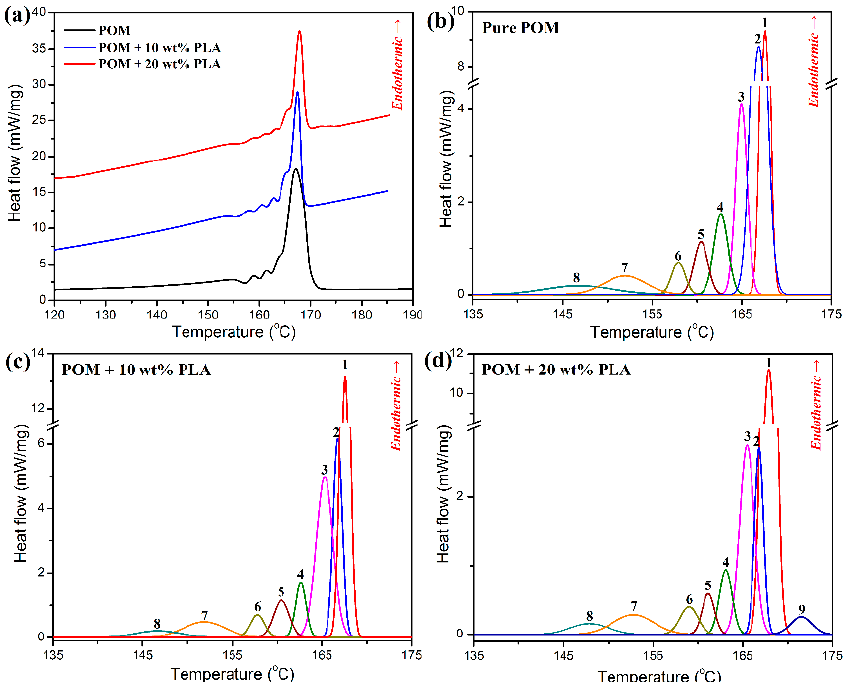
Figure 4. ( a ) DSC survey curves of POM and its blends with PLLA. Successive self-nucleation and annealing (SSA) melting crystallization curves of ( b ) pure POM and its blends with ( c ) 10 wt % and ( d ) 20 wt % of PLLA.